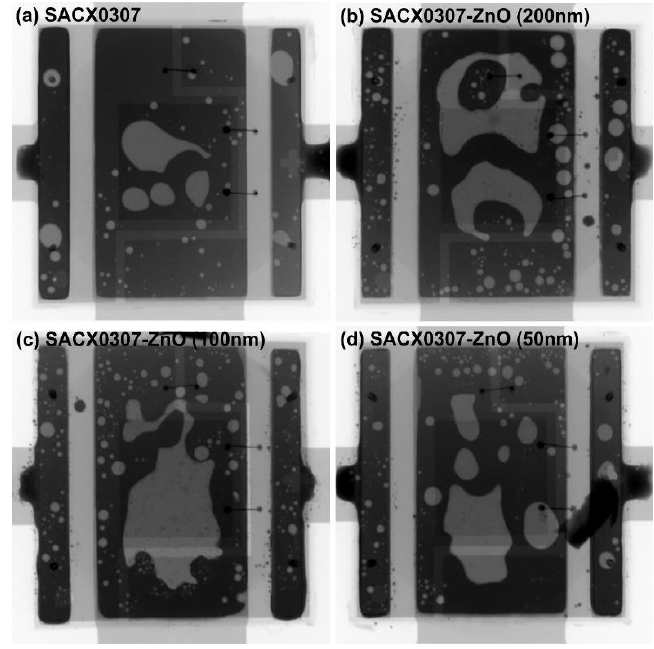
Figure 4. X-ray images of the different solder joints.